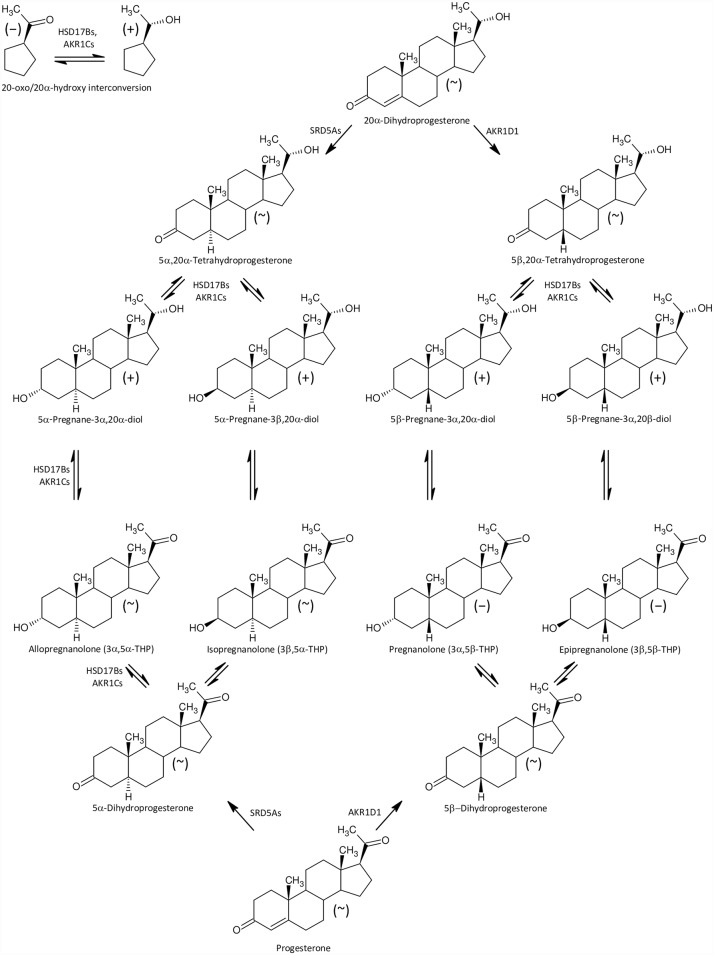
A simplified scheme of 5α/β-reductive progesterone and 20α-dihydroprogesterone catabolism and interconversion between the steroid 20-oxo and 20α-hydroxy-counterparts.The symbols in parentheses “+”, “~”, and ”−” represent increased, unchanged steroid and decreased steroids levels, respectively, in the ICP group.